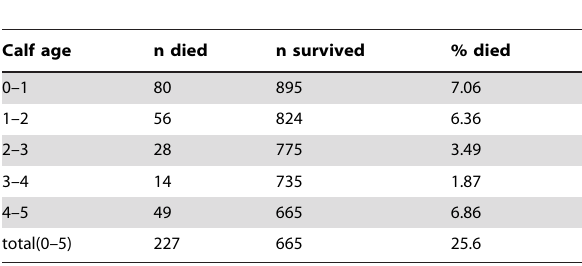
Table 2. Mortality of Asian elephant calves by each age group from birth to age of 5